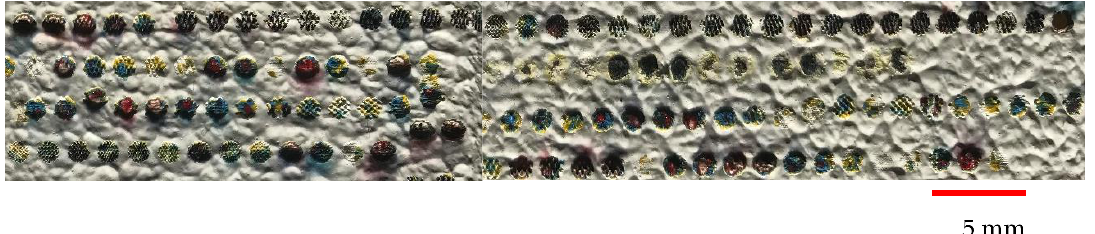
Figure 7. Preliminary experiments conducted by applying smaller circle size and the following ranges of laser input